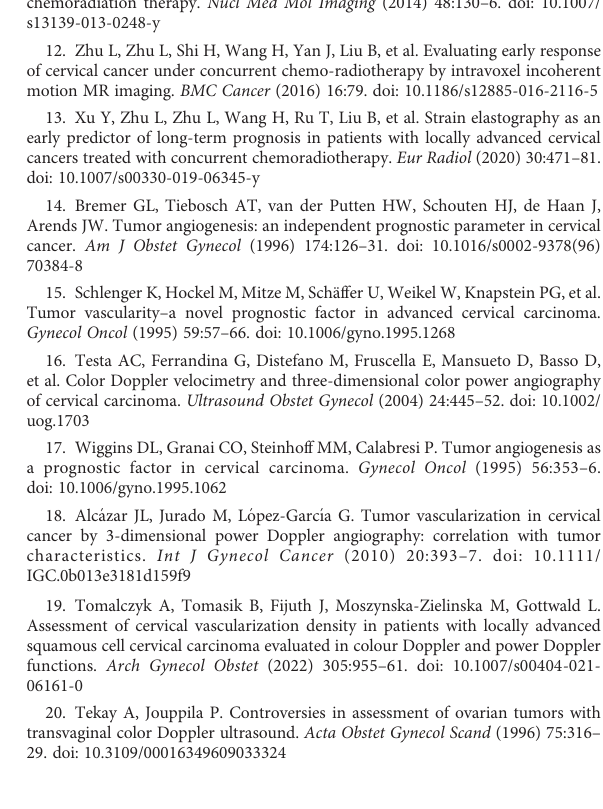
SUPPLEMENTARY FIGURE 1 Receiver-operating characteristic (ROC) curve of morphological changes duringtheCRT.Maximumtumordiameter(Dmax, A )andtheirpercentage changes ( D Dmax, B ) cannot predict the long-term prognosis at 3